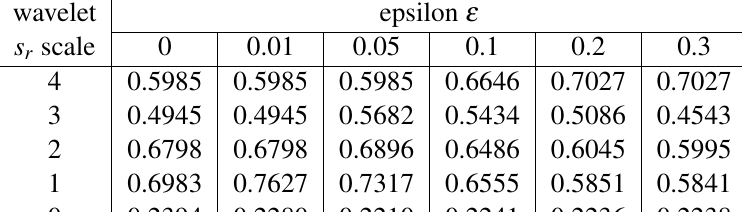
Table 6. Nearness Measures of B & M images based on contour lengths.